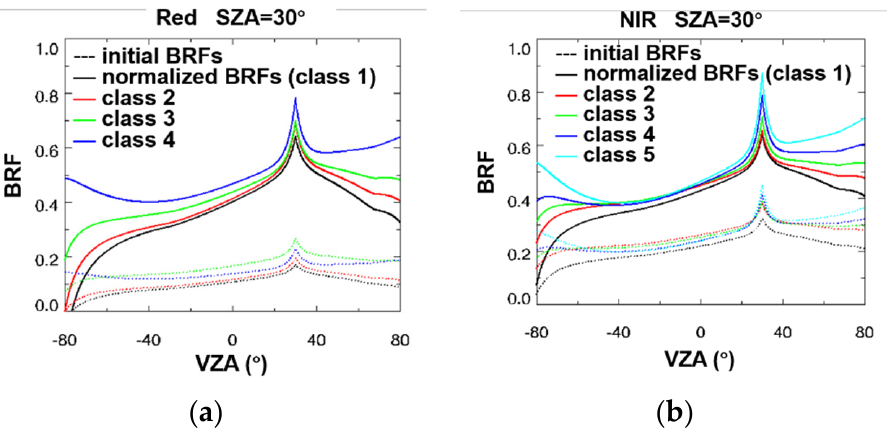
Figure 11. BRDF archetypes that were extracted from the 1066 sets of daily accumulated high-quality AHI observations. ( a ) Red band. ( b ) NIR band. Table 8. AFX ranges for the BRDF archetypes that were derived from the 1066 sets of daily accumu- lated high-quality multiangle observations.